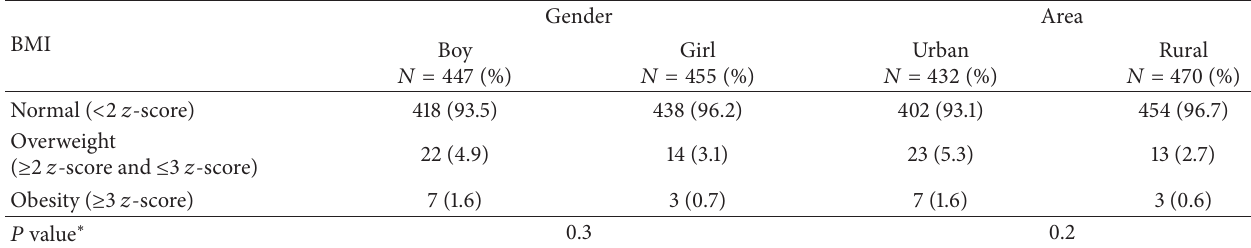
Table 3: The distribution of BMI in sex and area.